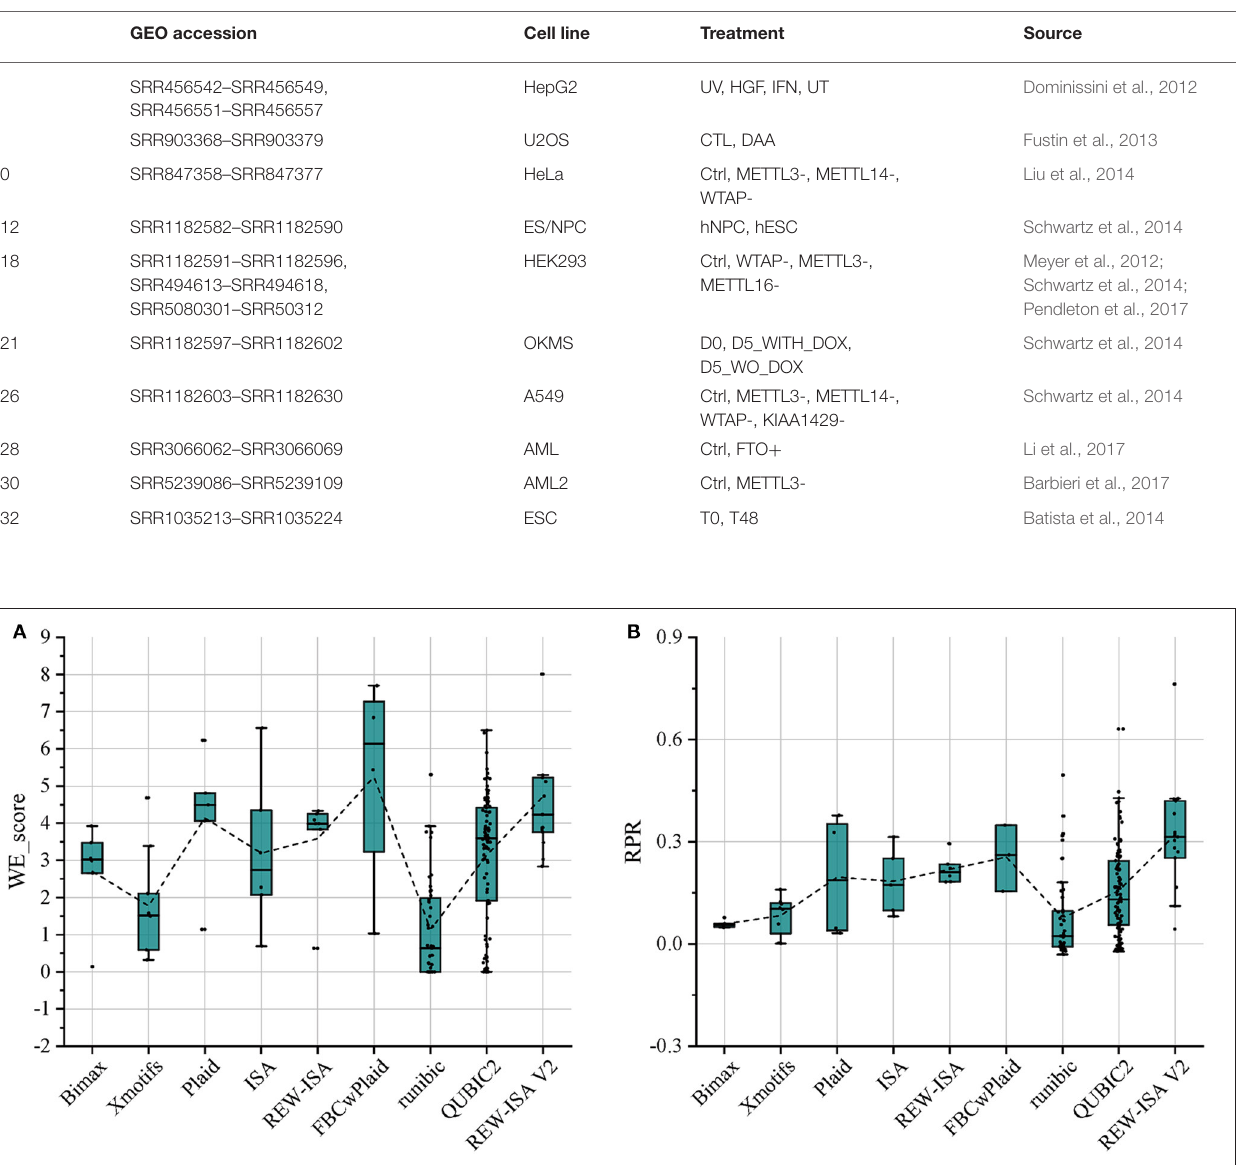
TABLE 1 | MeRIP-seq datasets used in the study.